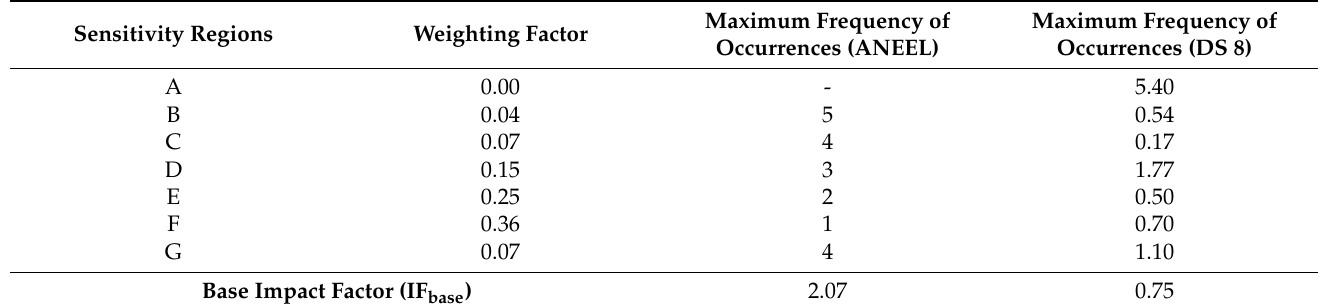
Table 8. Weighting factors and limits for voltage sag frequency at sensitivity regions. Sensitivity